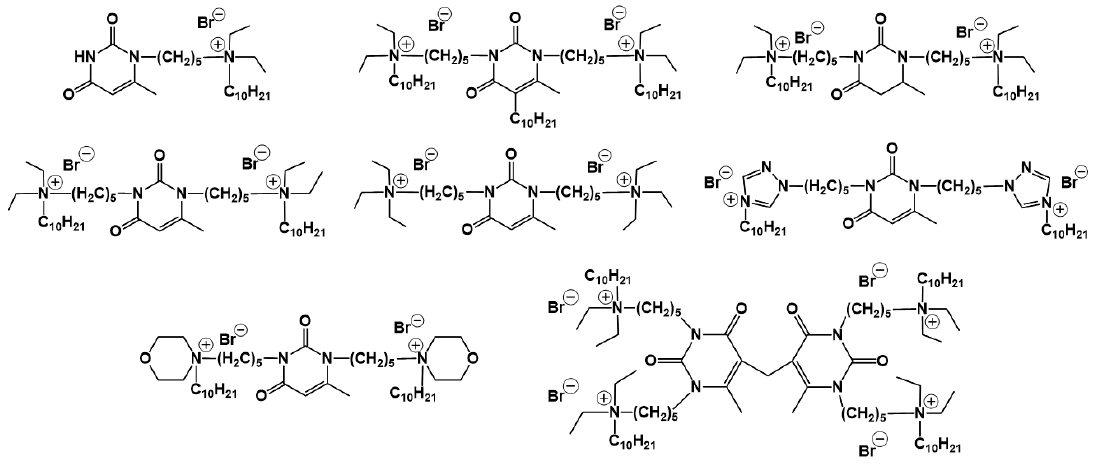
Figure 4. Some representatives of cationic pyrimidine-based nucleolipids [102–105].